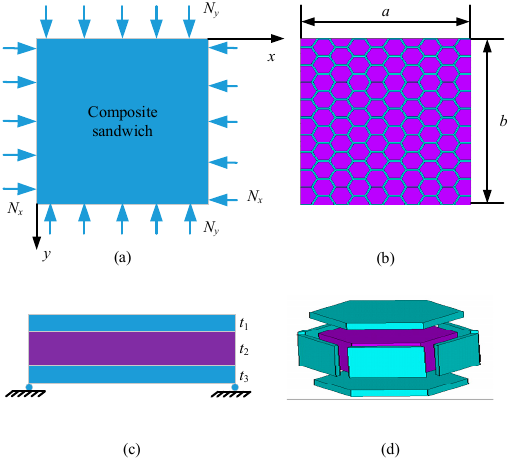
Figure 1. Buckling of the honeycomb reinforced laminated composite plate with two-direction forces. ( a ) Macroscopic of composite laminate sandwich; ( b ) Honeycomb reinforced composite core layer; ( c ) Boundary condition of the sandwich structure; ( d ) A representative unit cell of the sand-